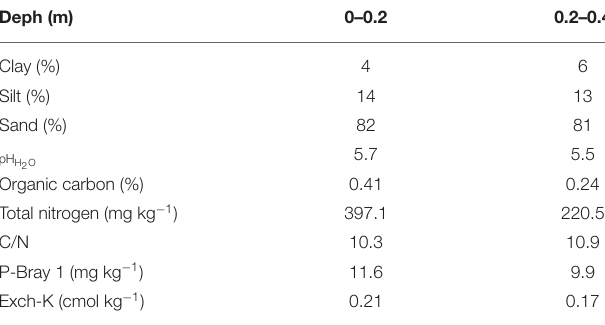
TABLE 1 | Initial soil chemical and physical properties of the experimental